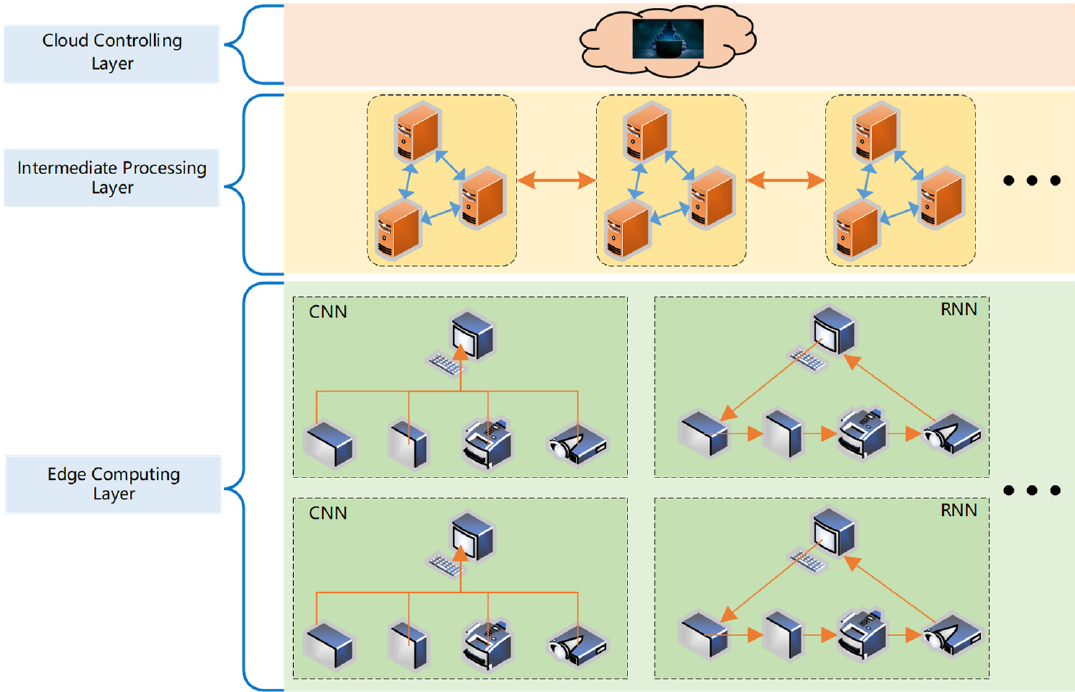
Figure 9. AIBot architecture.